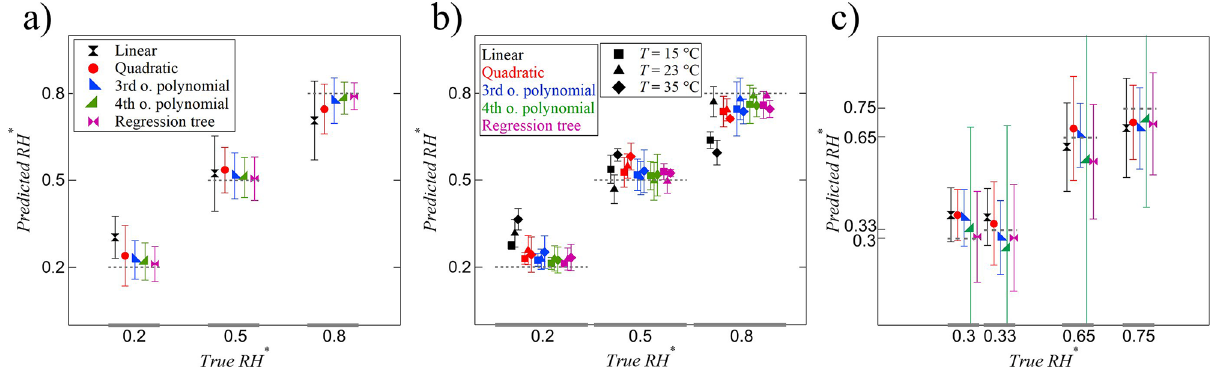
Figure 3. Relative humidity regression results: ( a ) test set; ( b ) validation; ( c ) estimation. Markers for all colors in ( b ) represent different temperatures as shown in legend. Markers and colors in ( c ) are the same as in ( a